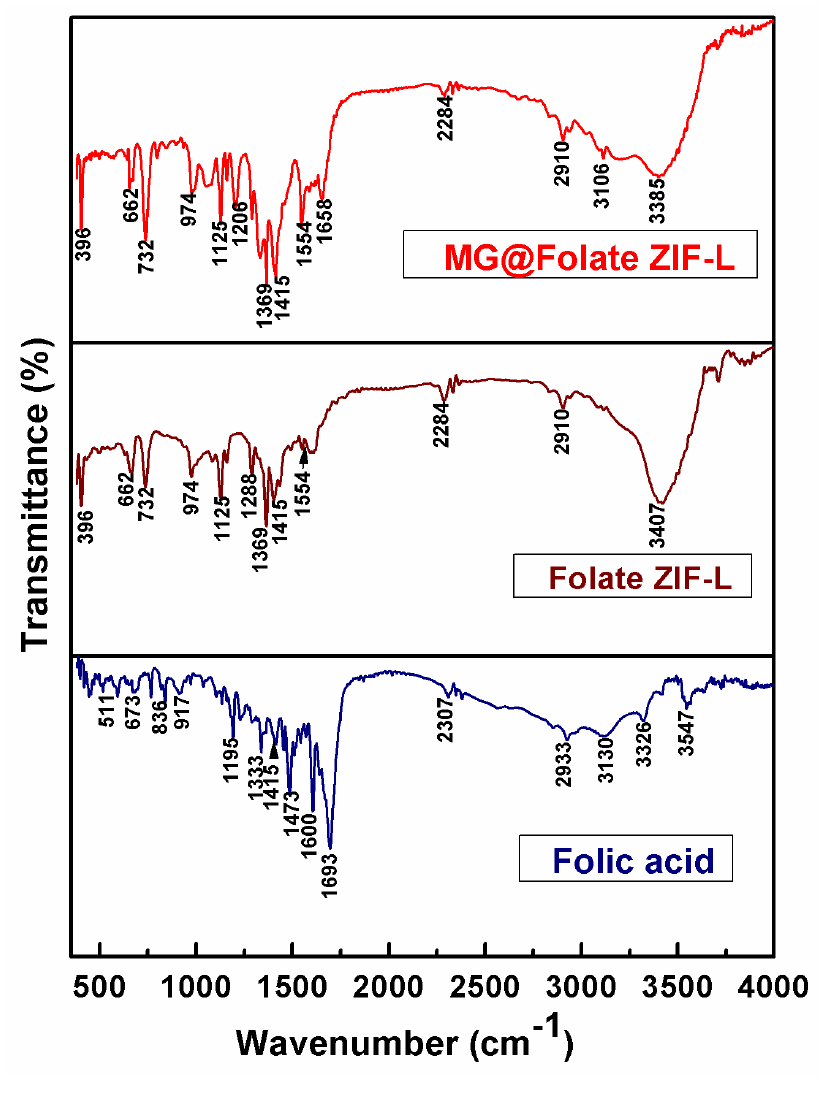
Figure 3. FTIR spectrum of Folate ZIF-L (brown), MG@Folate ZIF-L (red) and folic acid (blue).